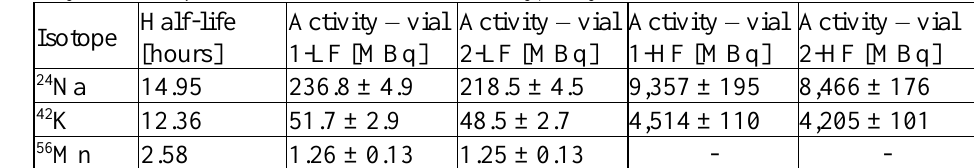
Table 1: Activity of the isotopes detected at Texas A&M University, decay-corrected to the end of activation. Half-life Isotope